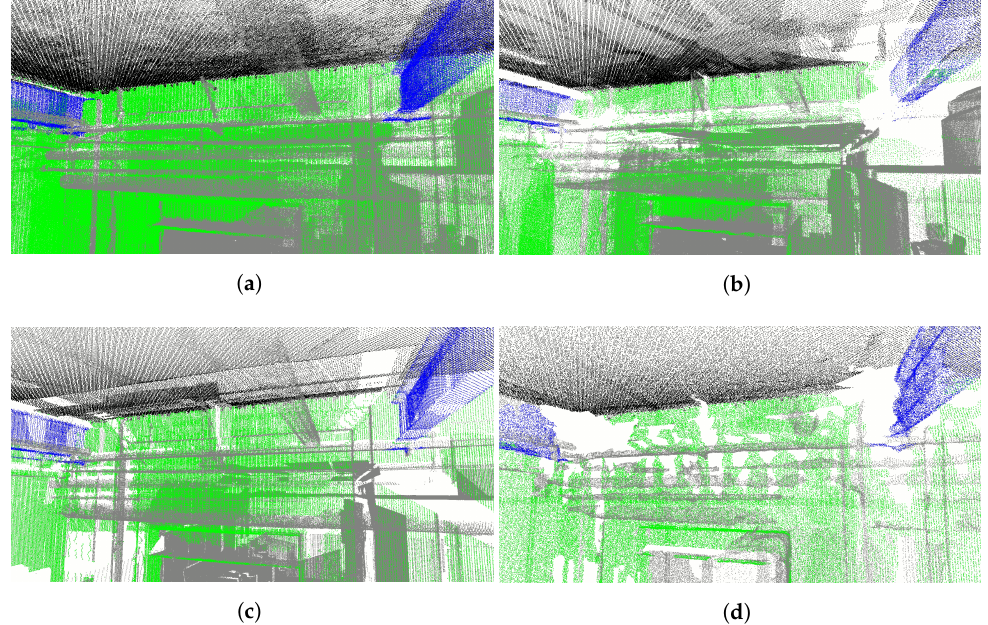
Figure 12. Resolution shortcomings: The Hololens 2 has an order of magnitude lower resolution compared to the other three sensors. This results in narrow or small objects being misinterpreted or missed all together. The VLX and P30 generally have the highest density and give the most dense point cloud which makes it easier to visually identify smaller details. ( a ) VLX, ( b ) M6, ( c ) P30, and ( d ) Hololens